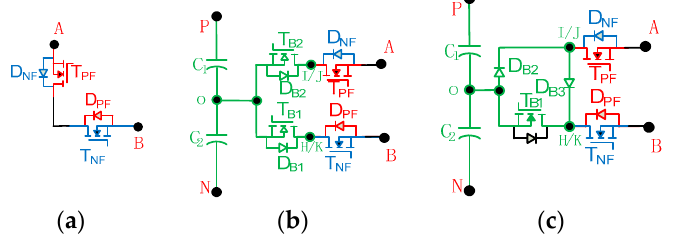
Figure 14. Direct Connection NPC cell circuits based on topology family without an extra diode. ( a ) freewheeling circuit; ( b ) NPC cell #1; ( c ) NPC cell #2.